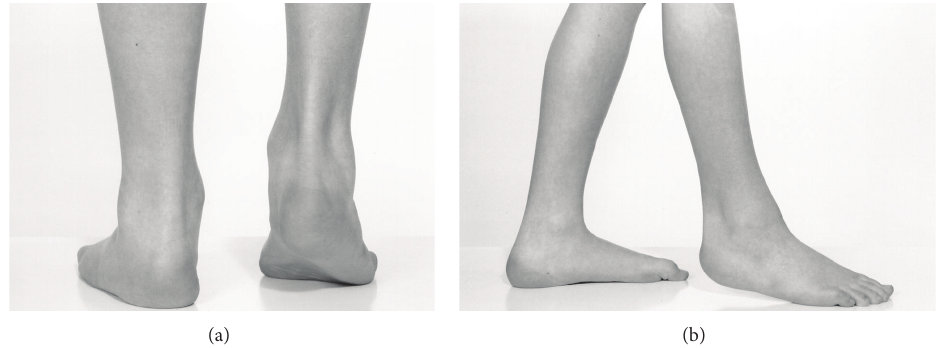
Figure 1: Right foot equinus and lack of dorsiflexion preoperatively: (a) posterior view, (b) lateral view.